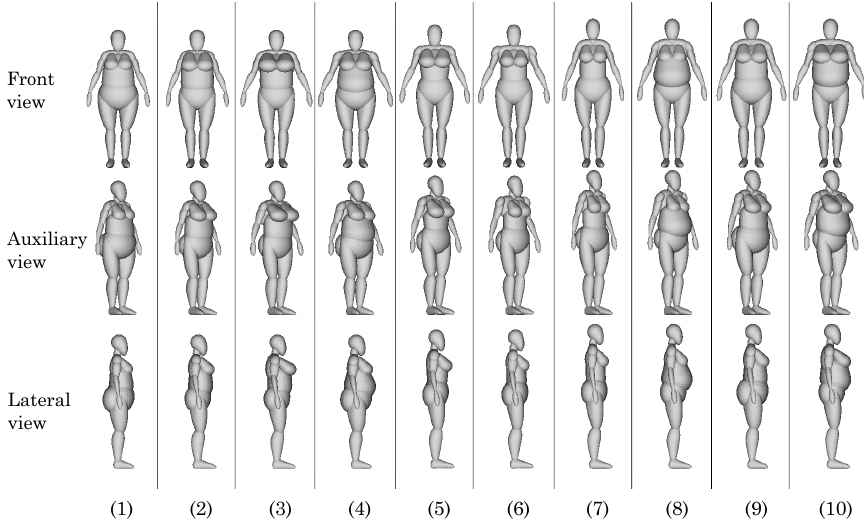
Figure 19. Cushion-based mannequins. These mannequins correspond to the same mannequins in Figure 18 with ellipsoids converted to